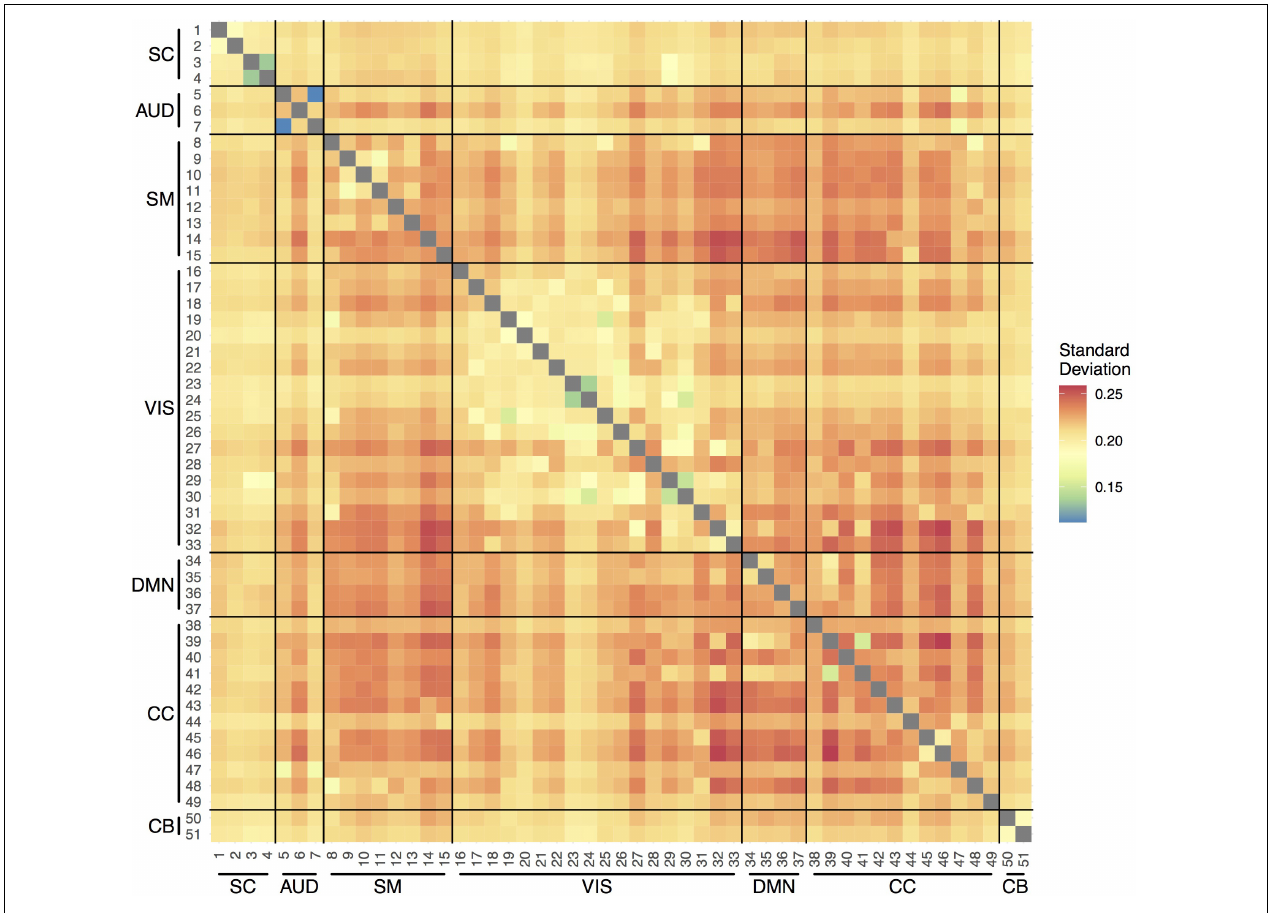
FIGURE 2 | Temporal variability in pairwise functional connections between the 51 components within scan session. SC, subcortical network; AUD, auditory network; SM, sensorimotor network; VIS, visual network; DMN, default-mode network; CC, cognitive control network; CB, cerebellar